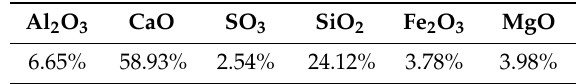
Table 1. Chemical composition of ordinary Portland